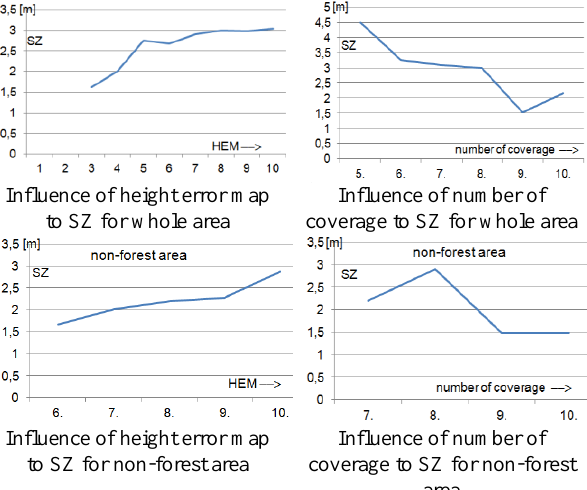
Fig.8: Dependency of height error map and coverage